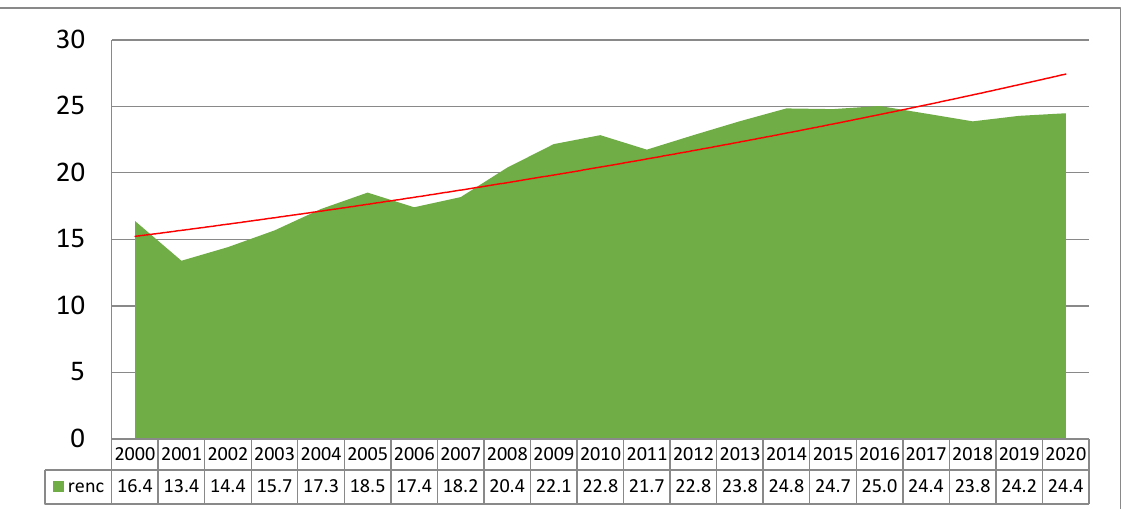
Figure 2. Renewable energy consumption (RENC). Table 2. Descriptive statistics of the variables.